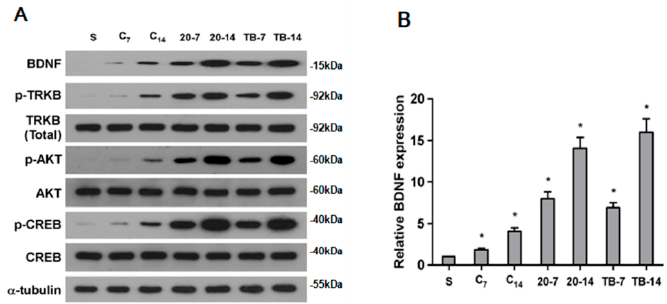
Figure 5. Expression of brain-derived neurotrophic factor (BDNF), phosphorylated-tropomyosin-related kinase B (p-TrkB), TrkB (total), phosphorylated-Akt (p-AKT), Akt, phosphorylated-CREB (cAMP responsive element-binding protein), and CREB in the ipsilateral hemisphere excluding the infarct area. ( A ) Western blot analysis of p-TrkB, TrkB (total), p-Akt, Akt, p-CREB, CREB and BDNF. Protein expression levels were normalized with α -tubulin; ( B ) Quantification of BDNF mRNA expression in the ipsilateral hemisphere excluding the infarct area. BDNF mRNA expression in the 20 Hz rTMS and